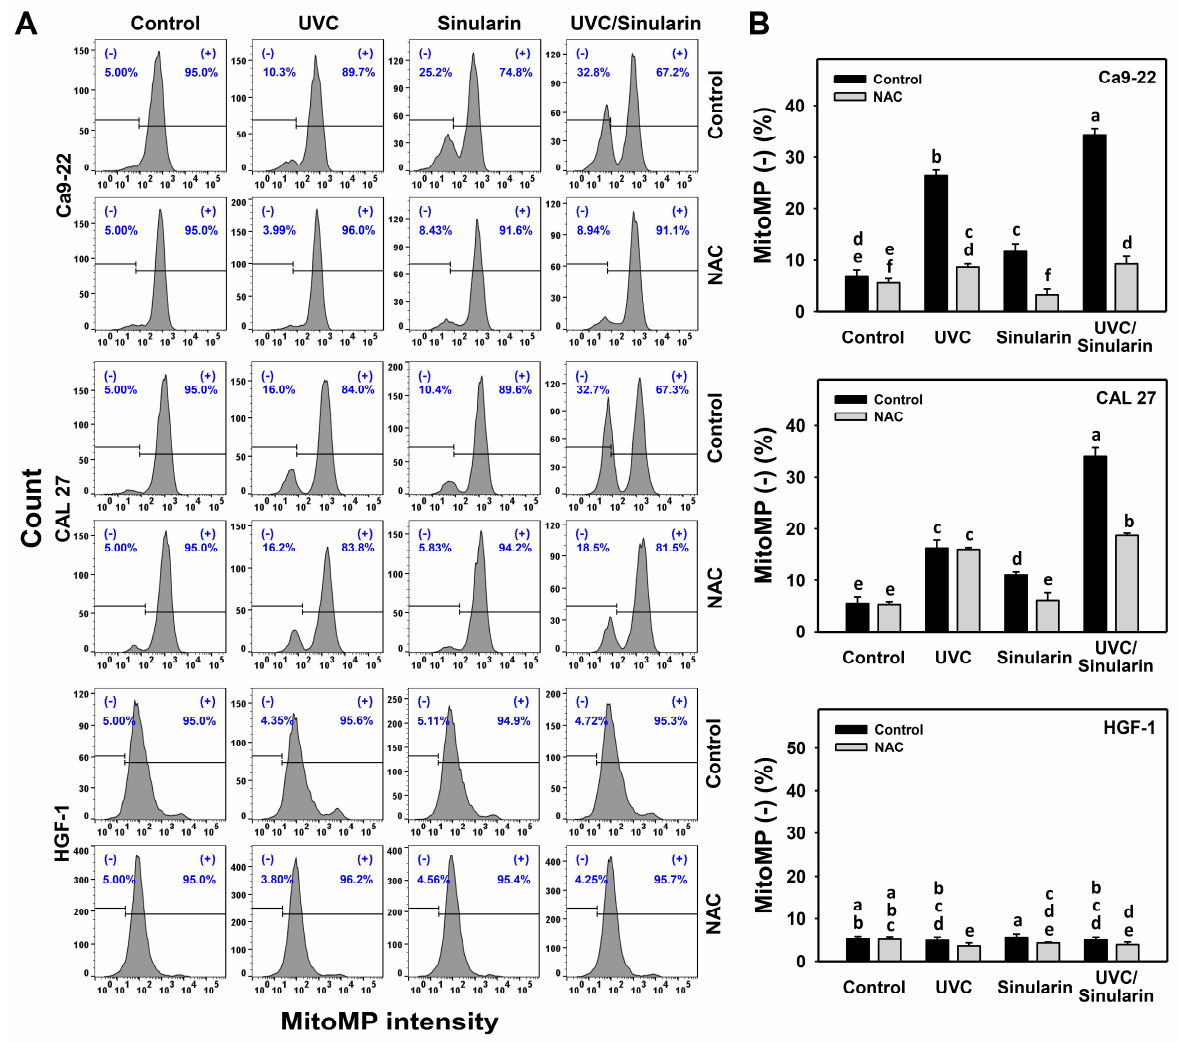
Figure 7. MitoMP expressions of UVC and/or sinularin treatments. Following the NAC preincubation (5 mM for 1 h) or not, the cells were arranged into four kinds of treatments: the control (0.1% DMSO in medium), UVC, sinularin, and UVC/sinularin for 48 h. The UVC and/or sinularin conditions were 12 J/m 2 , 2 μM and 10 J/m 2 , 3 μM for oral cancer cells (Ca9-22, CAL 27), and 12 J/m 2 , 3 μM for normal cells (HGF-1) for 48 h, respectively. ( A , B ) Patterns and quantifications for MitoMP analysis. (-) indicates MitoMP-negative (%). For the multi-comparisons, the treatments marked without repeated characters (a to f) differ significantly ( p < 0.05). The data were plotted as the mean ± SD ( n = 3).